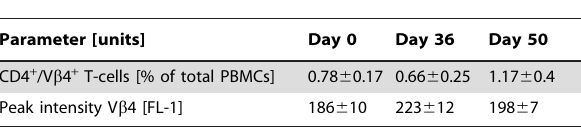
Table 3. Proportion of CD4 + /V b + cells and peak fluorescence intensity of the V b 4 signal in PBMCs of BDC2.5 TCR tg recipients after transfer of B-cells from donors vaccinated with TscFv BDC2.5.